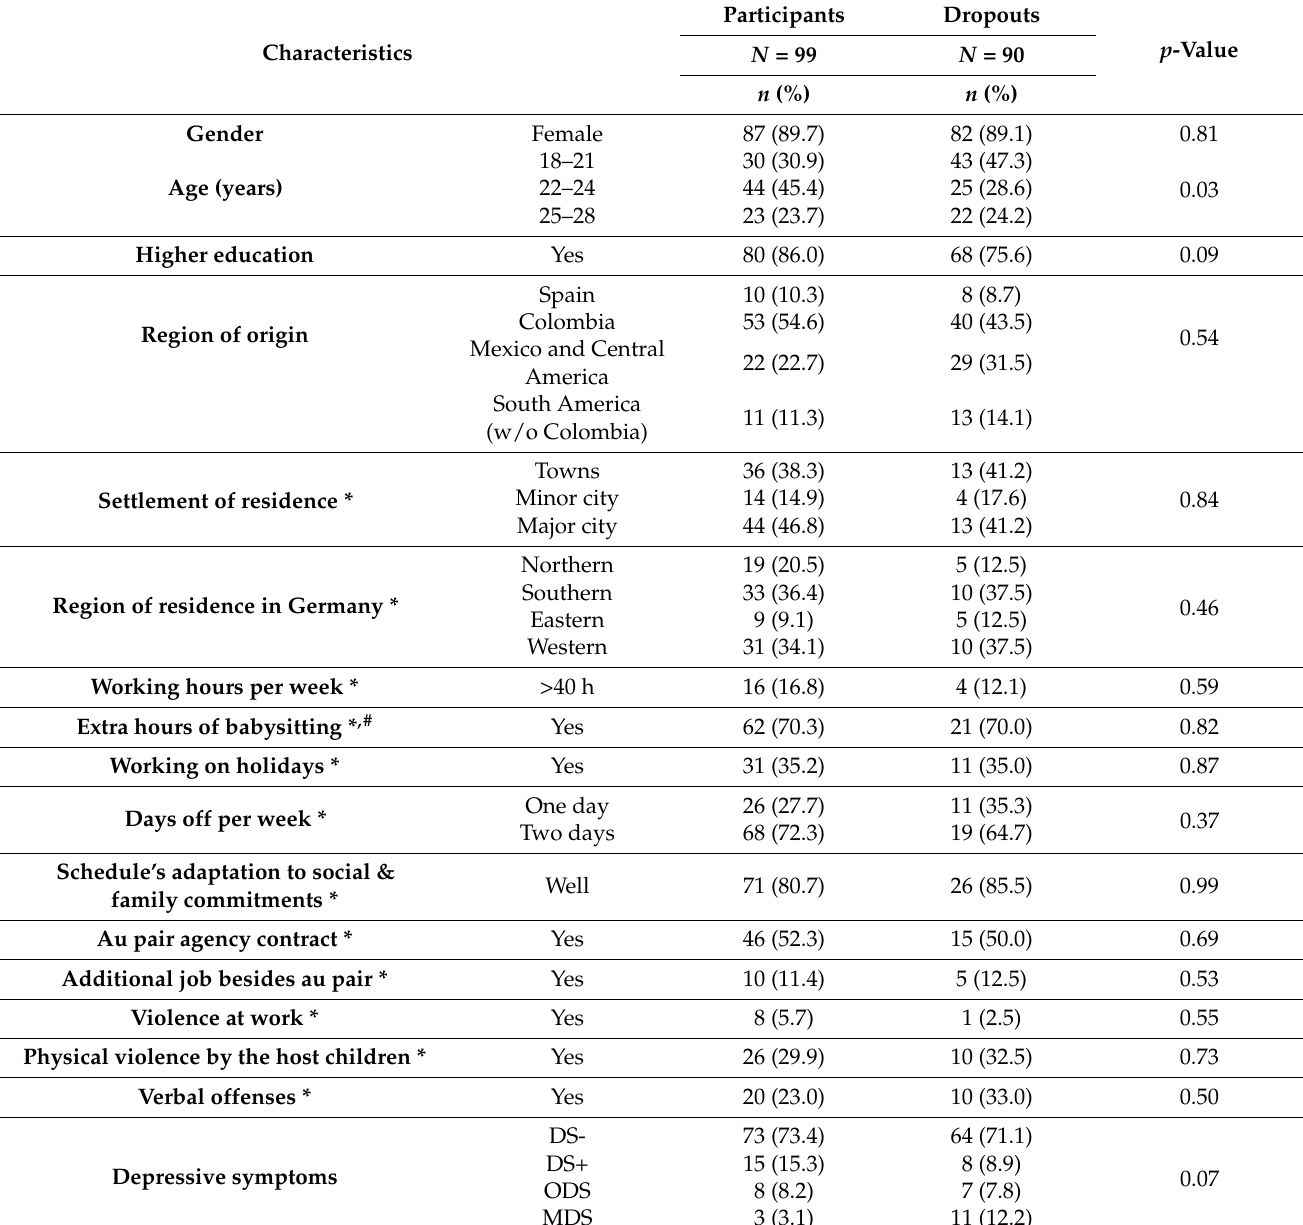
Table 1. Descriptive data of participants who remained in the study through all three time points and the participants who dropped out of the